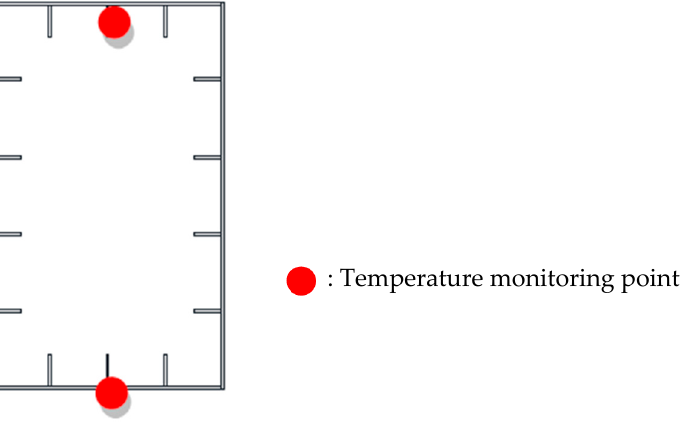
Figure 8. Temperature monitoring points of arch ribs (T6 to T8).